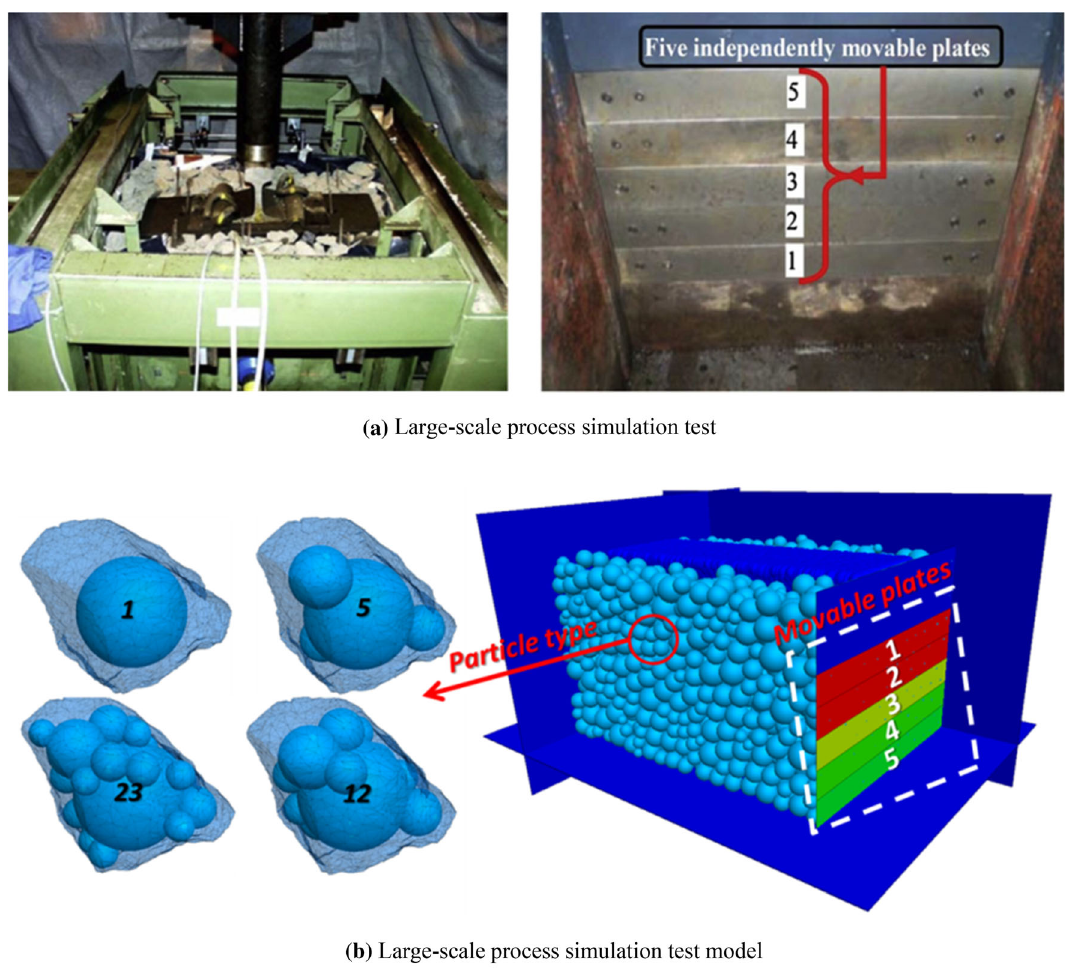
Fig. 3 Large-scale process simulation test and DEM model (Fig.3a reproduced from